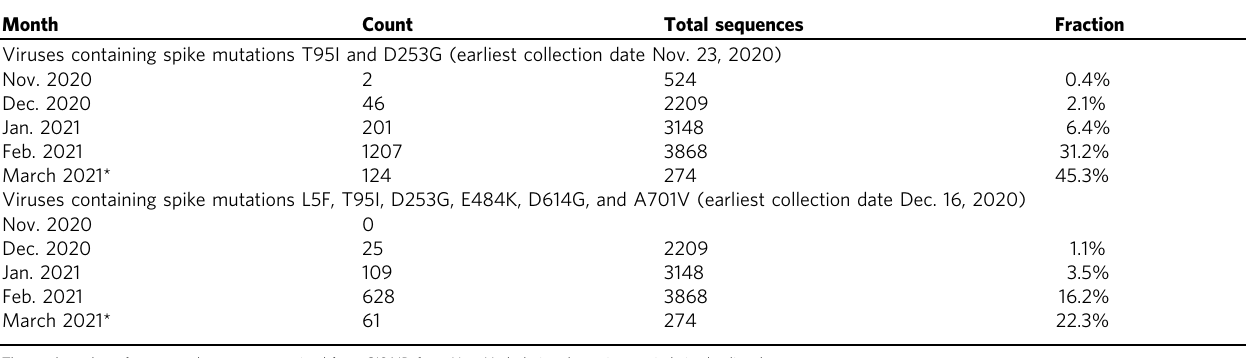
Table 2 Counts of virus genomes in lineage B.1.526 by month in New York State. Month Count Total sequences